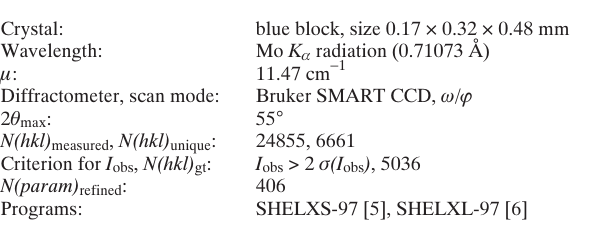
Table 1. Datacollection and handling.